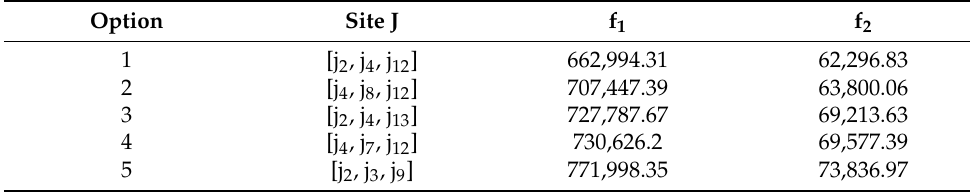
Table 5. Pareto optimal solution for the emergency center location.